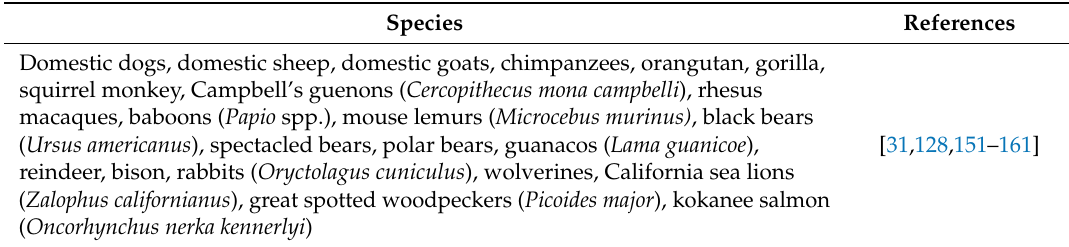
Table 3. Species exhibiting amyloid protein deposits (senile plaques) in the brains of ageing individuals.